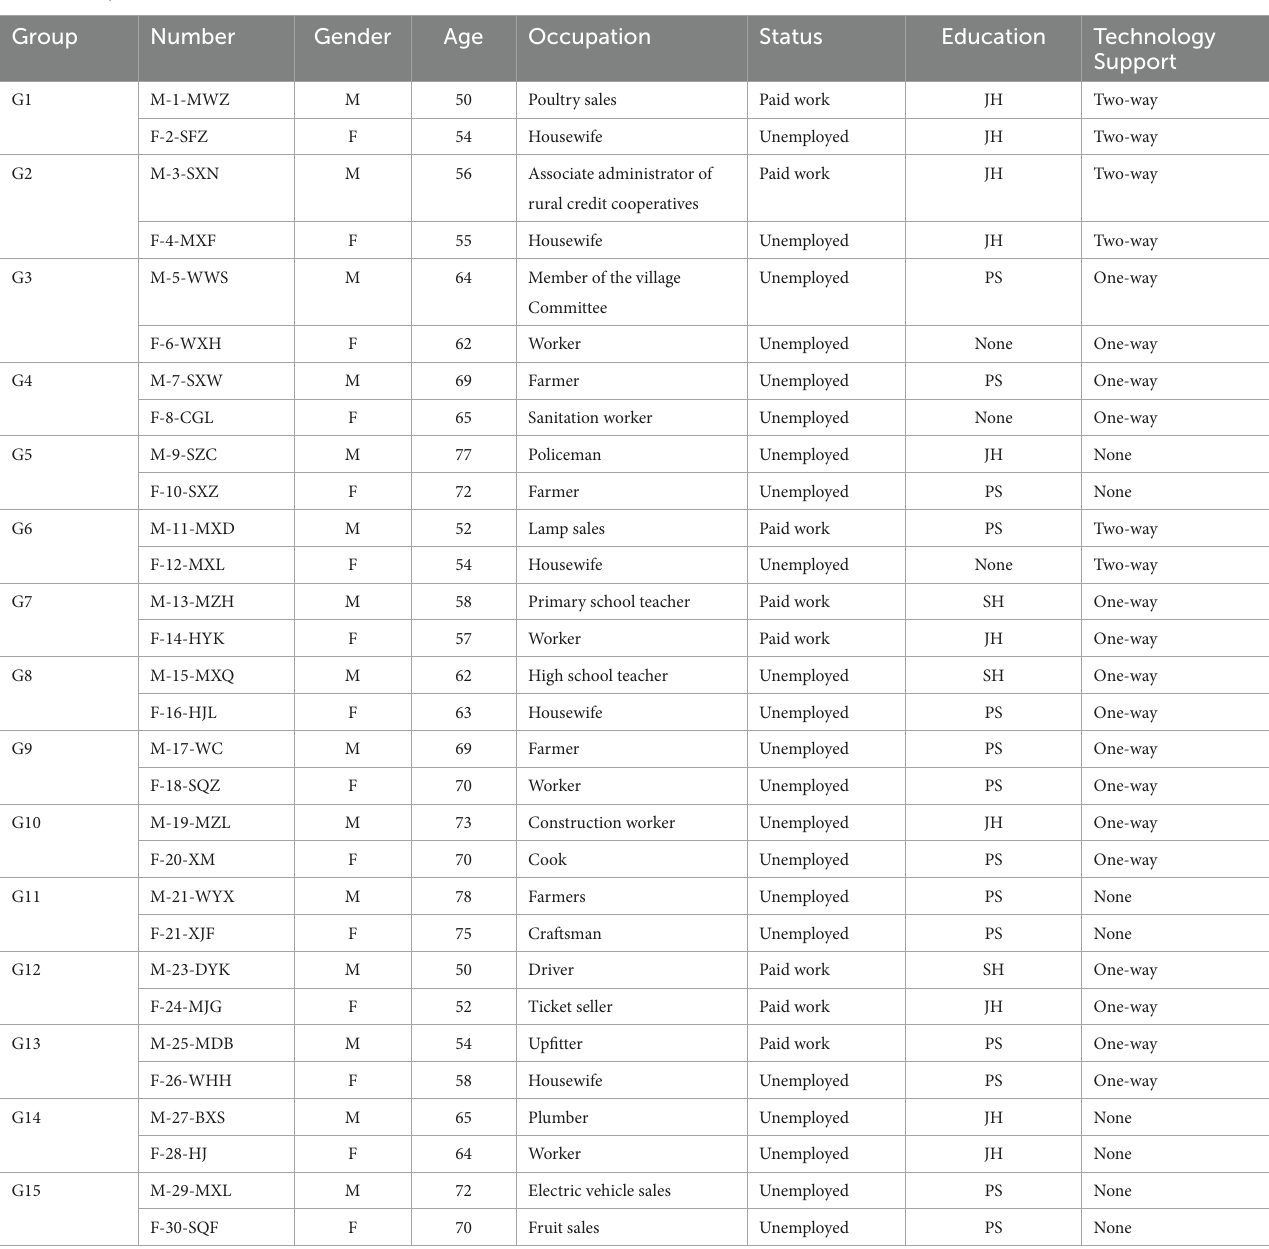
TABLE 1 Sample characteristics ( N = 30).